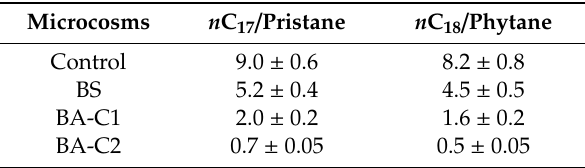
Table 3. Values of biodegradation indices in the di ff erent microcosms. The data are presented as the mean values ± SD ( n =